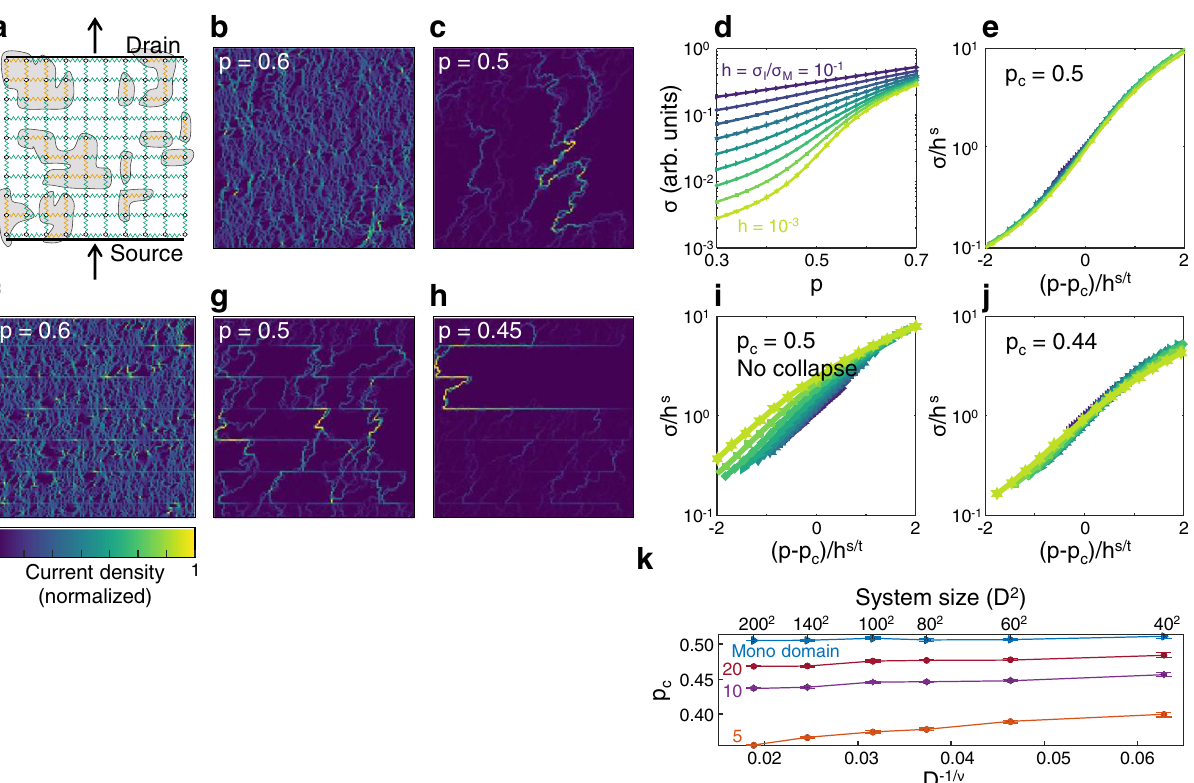
Fig. 3 Size dependence of the metal-insulator transition. a Illustration of the random resistor network, showing isolated insulating patches (yellow nodes) within the metallic (green nodes) network. b , c Current density maps obtained from individual realizations of a 128*128 network, at p ¼ 0 : 6 ( b ) and p ¼ 0 : 5 ( c ). The current was sourced at the bottom side of the square, and drained at the top. At p ¼ 0 : 5, the current fl ows along the expected subdimensional fractal. d The conductivity of the network, plotted as a function of p , for various bond conductivity ratios h . e The data in d rescaled with the universal critical exponents s ¼ 0 : 5 and t ¼ 1 : 3, showing data collapse at the critical concentration, p c ¼ 0 : 5. Representative realizations of the model with domain boundaries, for p ¼ 0 : 6 ( f ), p ¼ 0 : 5 ( g ), and p ¼ 0 : 45 ( h ). The current carrying backbone in g no longer consists of a single complicated path. Instead, shorter complex paths appear at a lower concentration ( h ), interconnecting the domain boundaries. The boundaries introduce long, straight lines into the backbone, inconsistent with the expected size scaling of a fractal. i , j Rescaled conductivity data for the critical concentration of the standard model, p ¼ 0 : 5 ( i ), and for the shifted critical point p ¼ 0 : 44 ( j ). k Size dependence of the critical concentration, for networks with various domain wall spacings. c c The mono-domain network shows no size dependence, while the critical concentrations of multi-domain RRNs is lower for larger systems sizes. The size and detail dependence suggest that the transition is not universal. The error bars represent two standard deviations from the mean fi tted critical